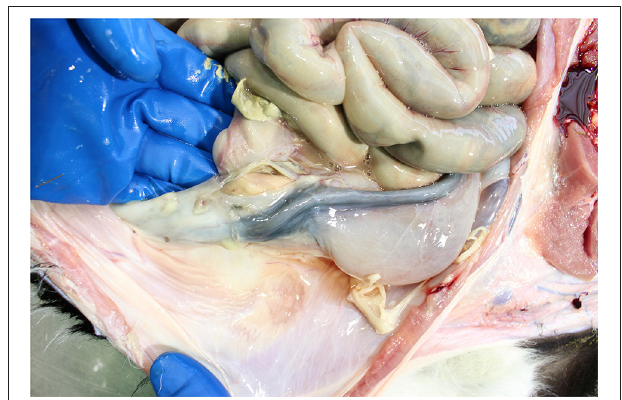
FIGURE 9 | Infection in and around the umbilicus